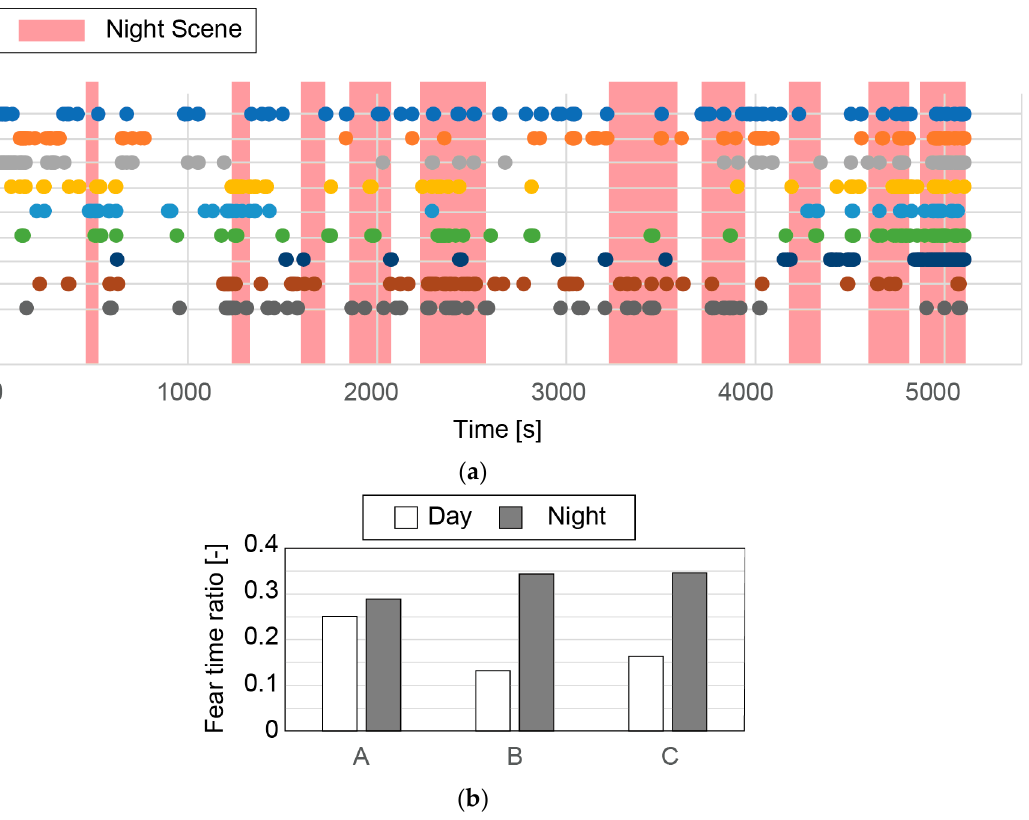
Figure 14. ( a ) Time when EEGs were within top 10% PSD for high- β / α for all three participants (A, B, and C) and all three measurement sites (Cz, T4, and T3). ( b ) Average number of measurement sites within top 10% PSD during day and night scenes in movie for each participant.